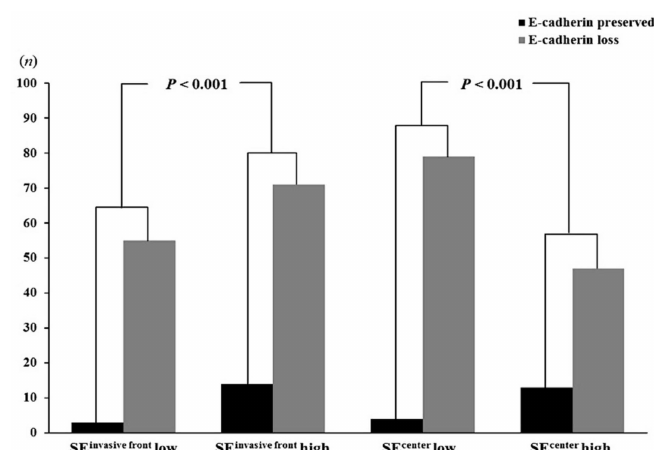
Figure 2. Immunohistochemical relationship between SE and E-cadherin in CRC. The expression pattern of SE is reversely correlated with E-cadherin expression in both the invasive front and the tumor center of CRC ( p <